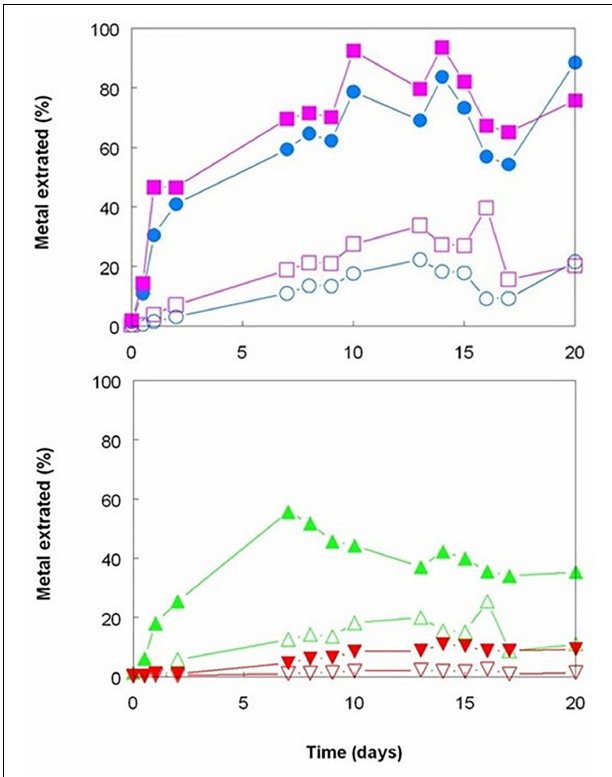
FIGURE 2 | Comparison of base metals solubilized during bioleaching of Shevchenko limonite by a mesophilic consortium of iron-oxidizing/reducing Acidithiobacillus spp. maintained at pH 1.8 and 35 ◦ C under aerobic (hollow symbols) or anaerobic (filled symbols) conditions. Key: concentrations of